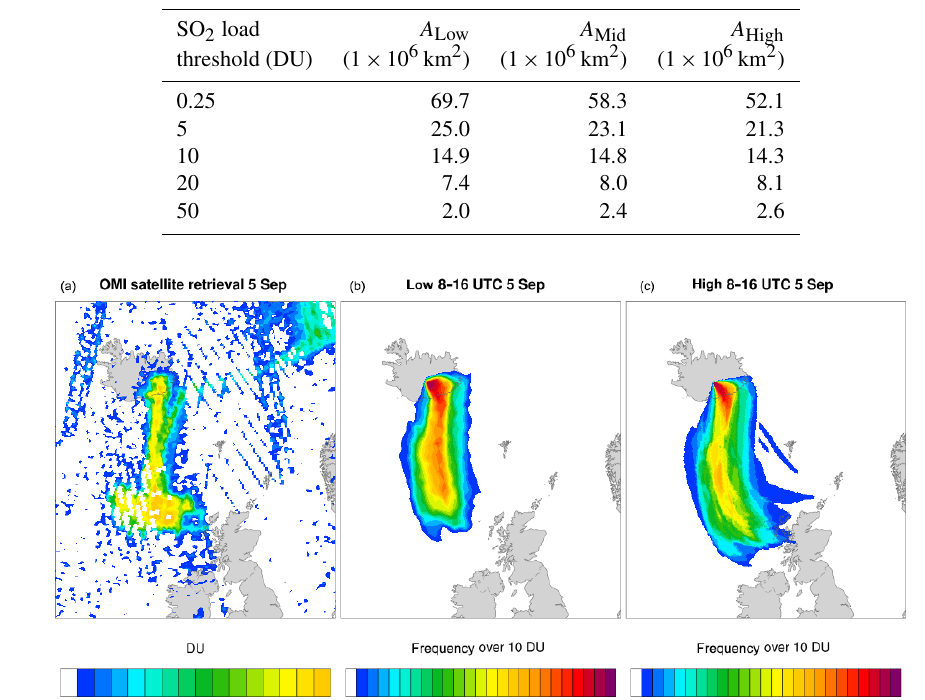
Table 2. Total area A where SO 2 loads are above a given threshold, found on average in members of the low, mid, and high resolution ensembles (see Table 1). Areas are accumulated at the end of a 48h forecast, corresponding to Figs. 1 and 2.